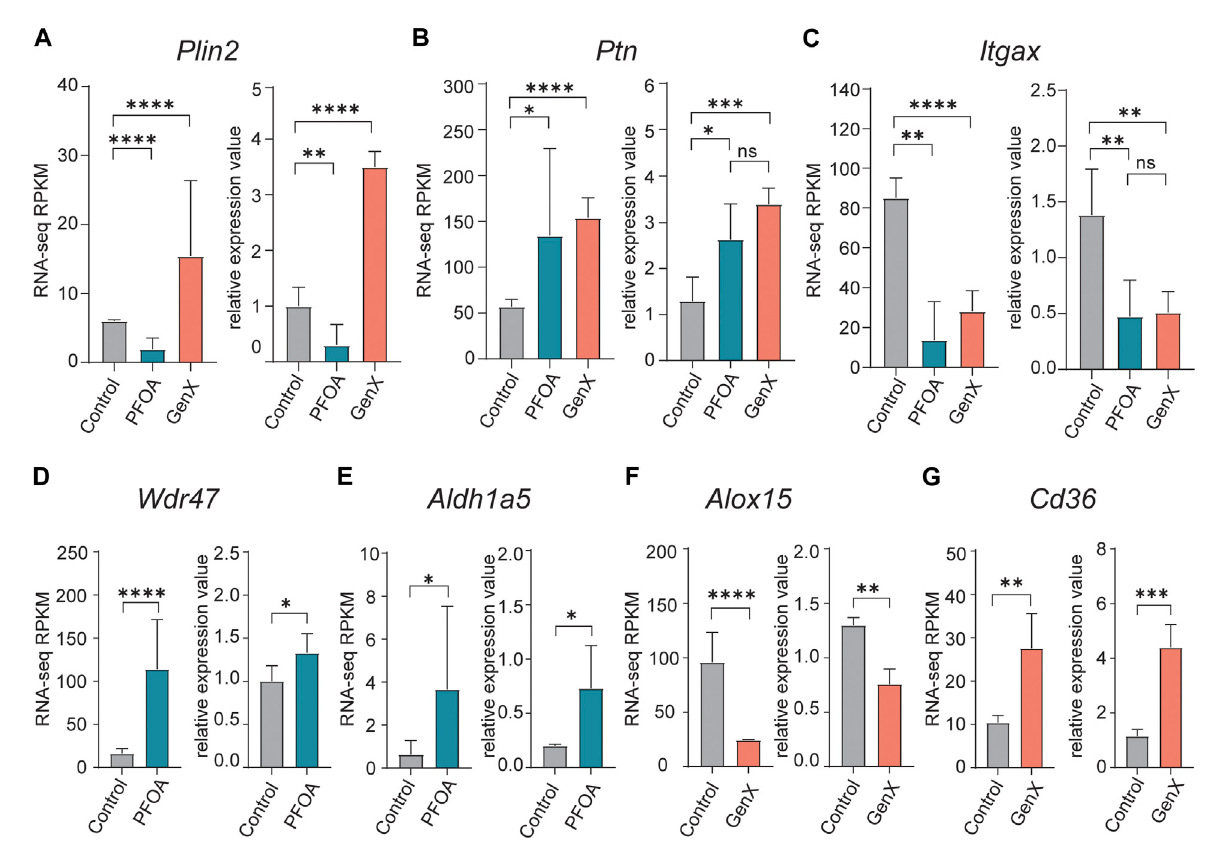
FIGURE 4 QuantitativereversetranscriptionPCRvalidationofupregulatedanddownregulatedDEGsidenti fi edinthePFOAandGenXtreatmentgroups. (A – G) Bar plots of qRT-PCR relative quanti fi cation and RNA-seq RPKM (Reads Per Kilobase of transcript per Million mapped reads) values for selected DEGs. (A) Plin2 , (B) Ptn , (C) Itgax , (D) Wdr47 , (E) Aldh1a5 , (F) Alox15 , (G) Cd36 .FortheRNA-seqRPKMlevel,signi fi cancewasdeterminedby q -valuesinedgeR(*, q